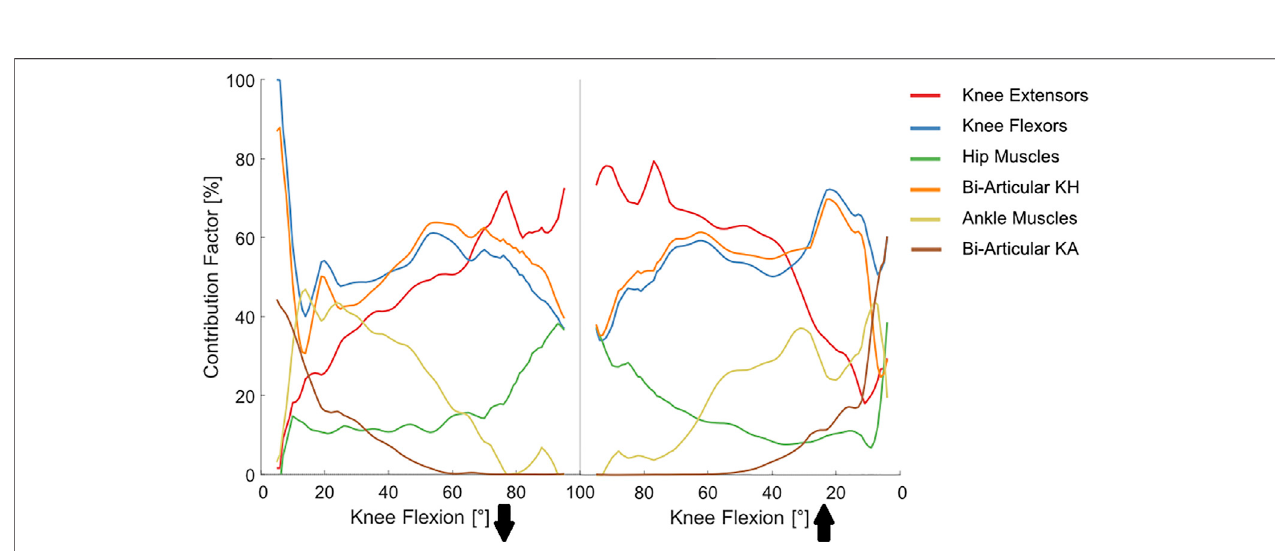
FIGURE 6 | Contribution of different muscle groups toward the overall variability in KCF estimates. Solid lines represent average contributions obtained from the general Monte Carlo analysis with a total number of 72,000 joint reaction force simulations (2000 iterations per subject and muscle group). KH (Knee-Hip) and KA